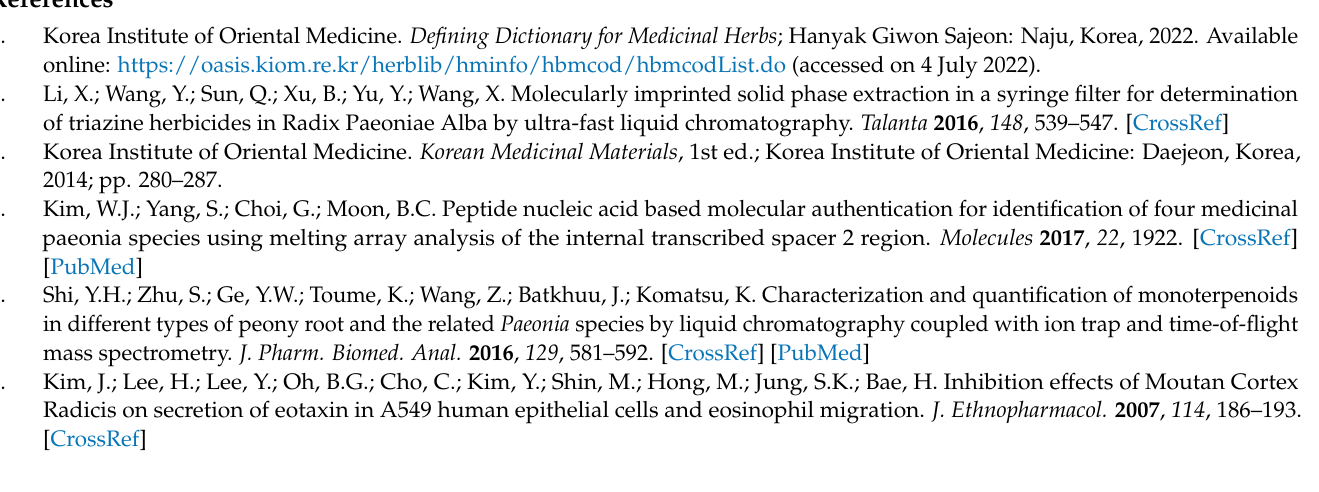
Figure S2. Multiple sequence alignment of the internal transcribed spacer (ITS) region of 35 Paeonia accessions. Figure S3: Multiple sequence alignment of the rbc L region of 35 Paeonia accessions. Figure S4. Assessment of the specificity of SCAR primers using 21 herbal medicine-related plant species. Figure S5. Morphological assay of PR and MRC samples sold in the Korean herbal market. Figure S6. Multiple sequence alignment of the internal transcribed spacer (ITS) regions of PR and MRC sold in the Korean herbal